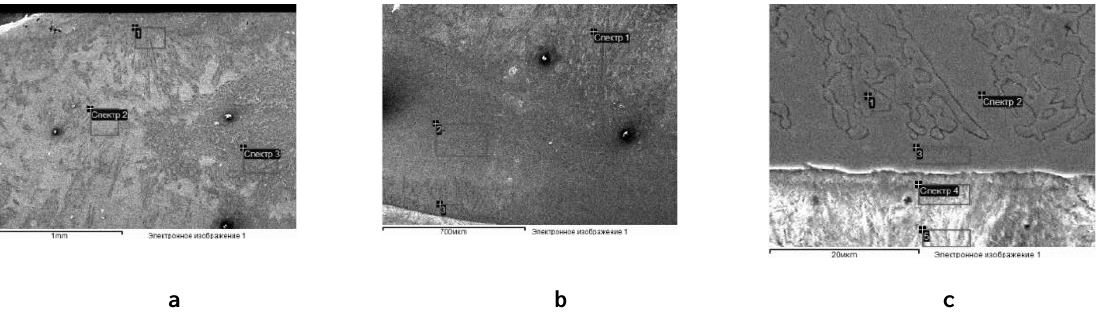
a b c Fig.11. Electronic photographs of the structure of the surfaced stripes with T-620 electrode with a non-magnetic fraction modification of the detonation charge indicating XREPA zones: a - surfacing surface; b - middle; c - heat-affected